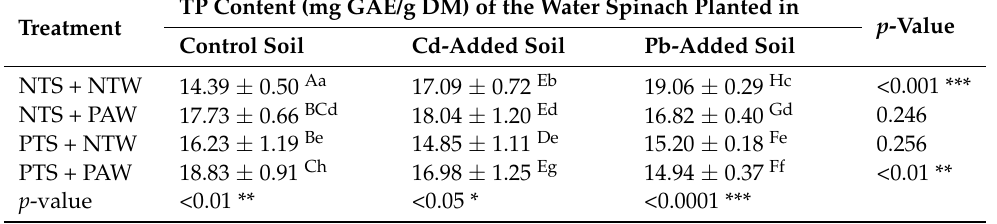
Table 3. Comparison of TP content in water spinach with different plasma treatments grown in different soil of the Phase-1 pot experiment.